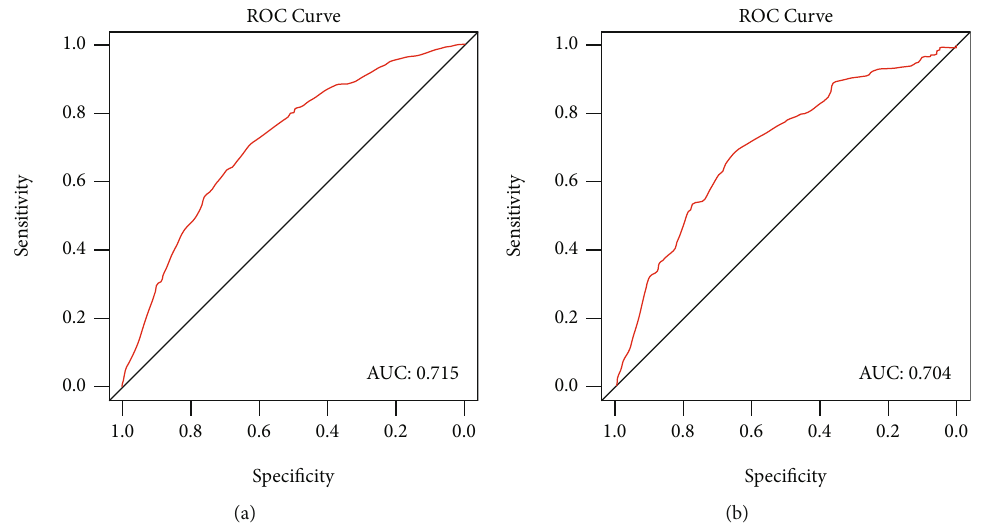
Figure 4: Receiver operating characteristic (ROC) curve and the under curve (AUCs) of ROC curves in the training cohort ((a) N = 1466 ) and the validation cohort ((b) N = 584